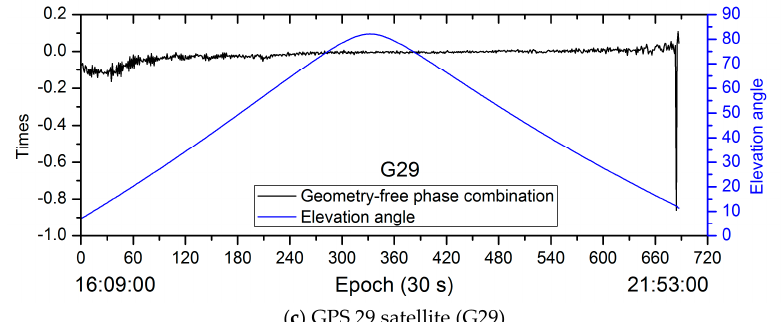
Figure 5. The times of the difference between wavelengths on two frequencies for the epoch-difference geometry-free phase combination and the corresponding elevation angle of G07, G05, and G29 satellites.